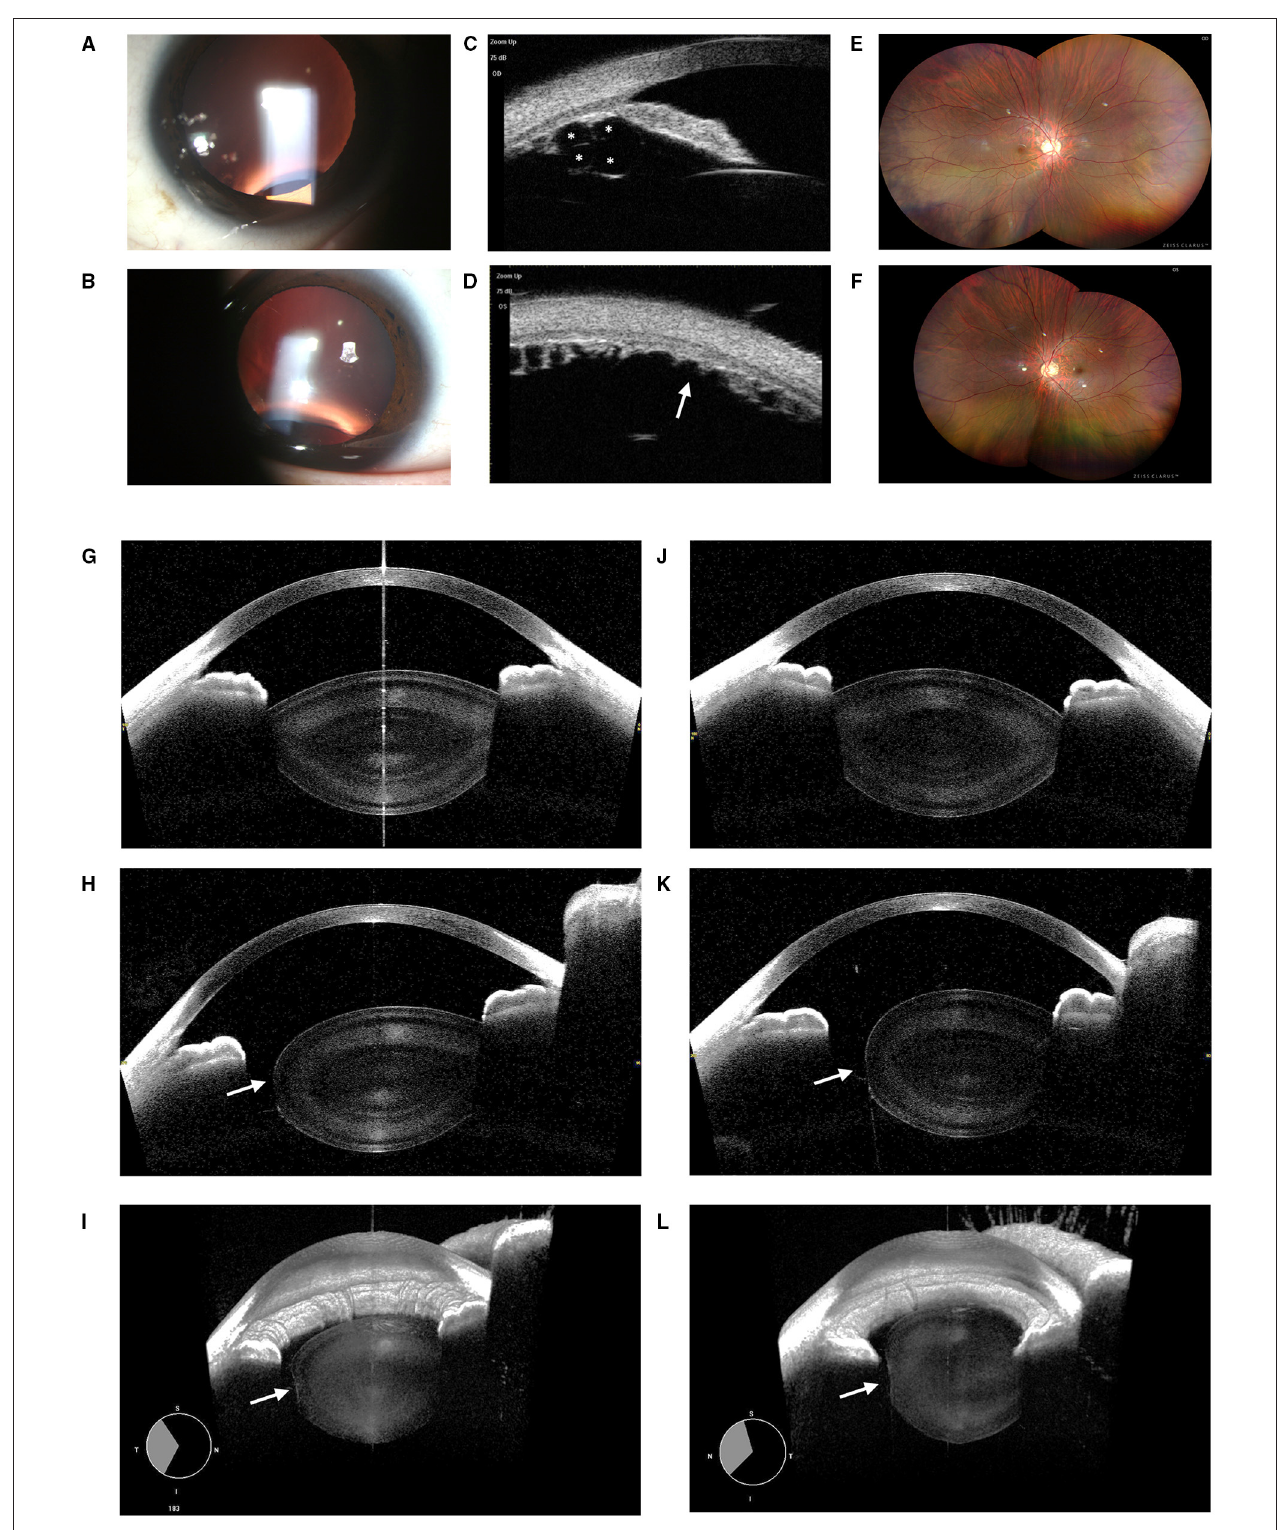
FIGURE 2 | Ocular images of Patient 2 with coloboma lentis (CL). (A) A slit-lamp photograph upon mydriasis showed the notching of the lens equator infero-temporally of the right eye. (B) A slit-lamp photograph upon mydriasis showed notching of the lens equator inferiorly of the left eye. (C) Multiple ciliary body cysts (indicated by “*”) were detected by the ultrasound biomicroscopy. (D) The absence of the ciliary body (indicated by “arrow”) was located toward the lens